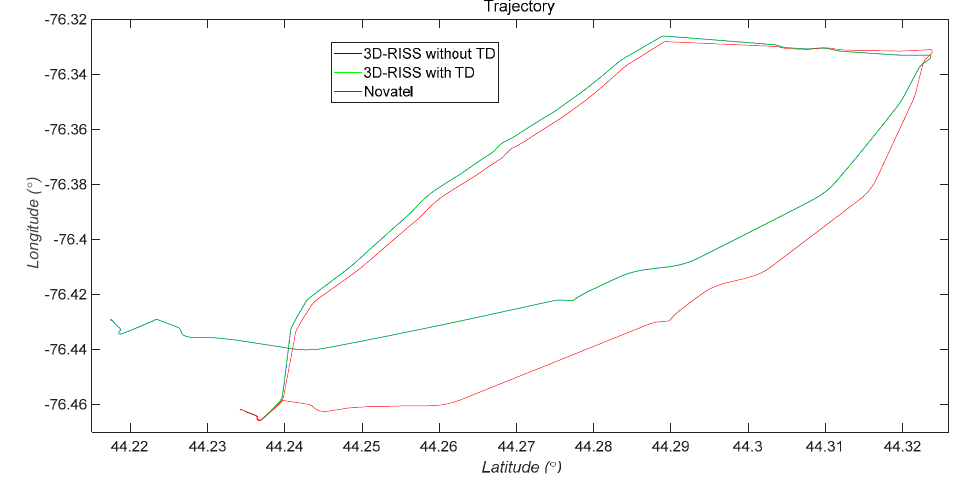
Figure 8. 2D trajectories comparison between the two RISSs and the reference. Table 1. Standard deviations of main navigation errors between the two 3D RISSs and the Novatel IMU. 3D RISS with Error Error 3D RISS with Original Error